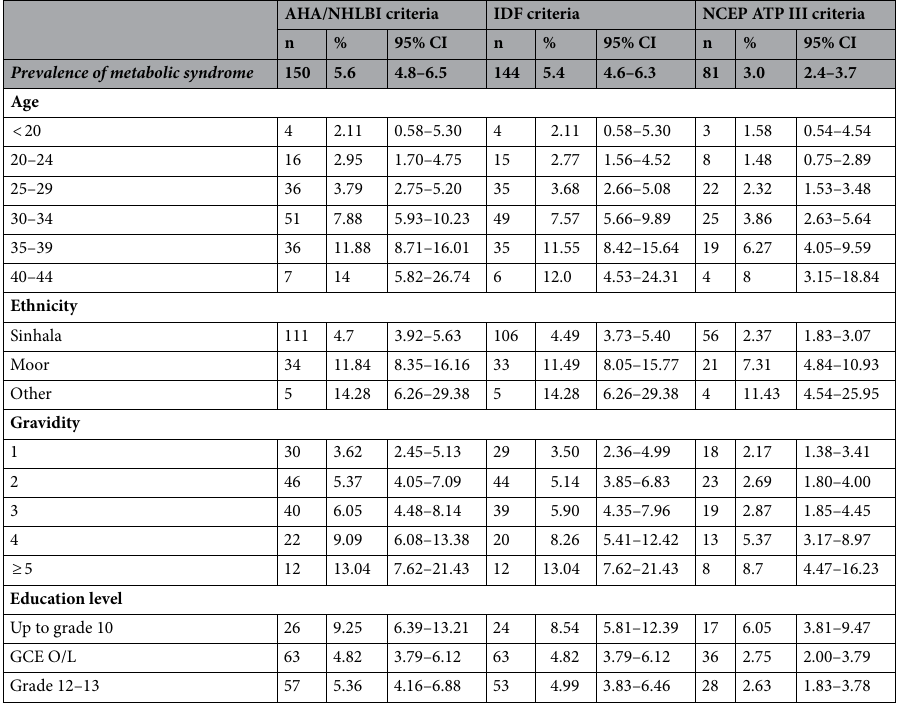
Table 5. Prevalence of metabolic syndrome among first trimester pregnant women in Anuradhapura district and its distribution by socio-demographic characteristics in the study sample. IDF International Diabetes Federation, AHA/NHLBI American Heart Association/National Heart, Lung and Blood Institute, NCEP ATP III National Cholesterol Education Programme Adult Treatment panel III, CI confidence interval, GCE O/L general certificate of education ordinary level.